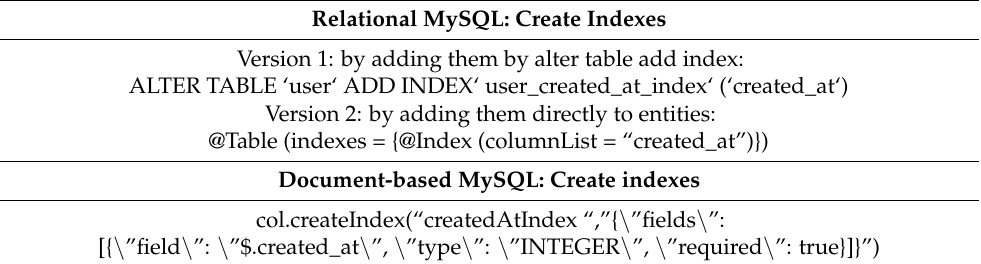
Table 1. Index creation.